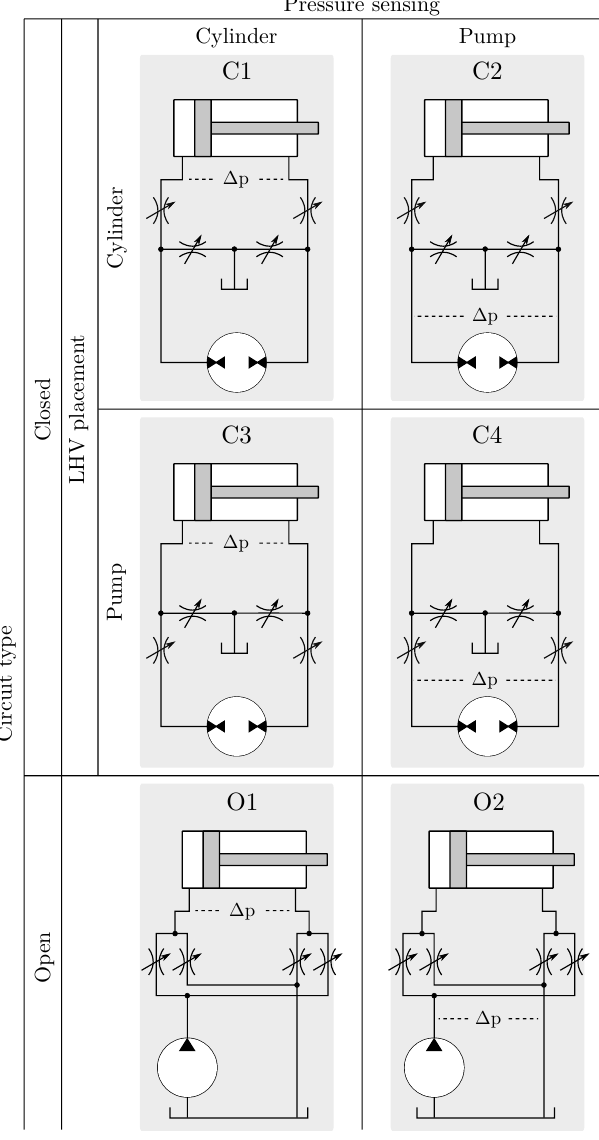
Figure 9. Circuit configurations analysed in this